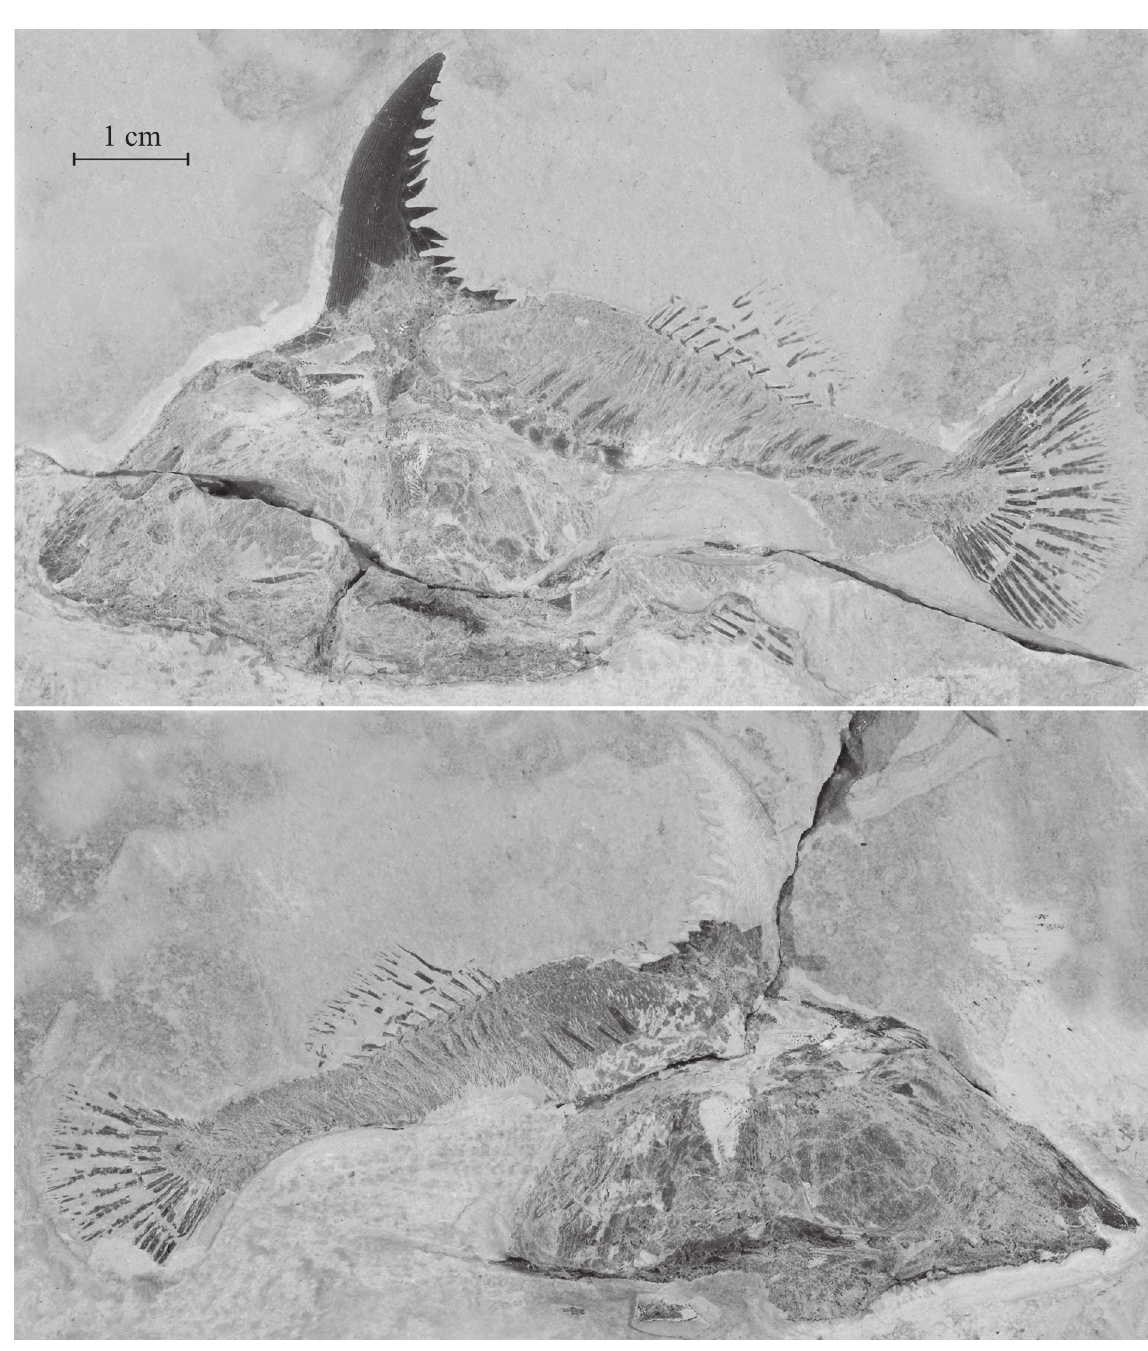
Fig. 7. Monocerichthys scheuchzeri gen. et sp. nov. Holotype CLC S-413a (above) and b (below).